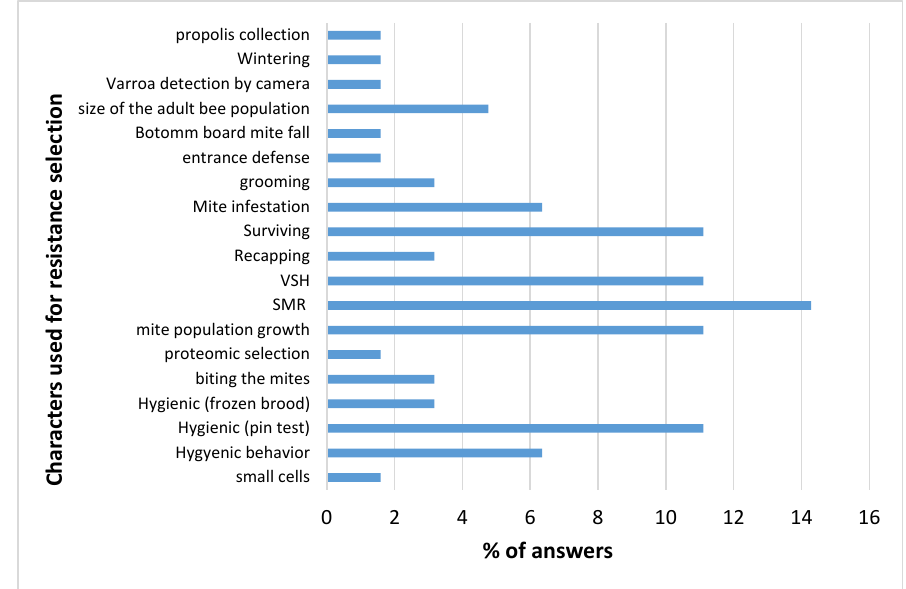
Figure 2. Frequency of different characters used for varroa resistance selection by honey bee breeders. Data are presented as the percentage of breeders using each specific character.